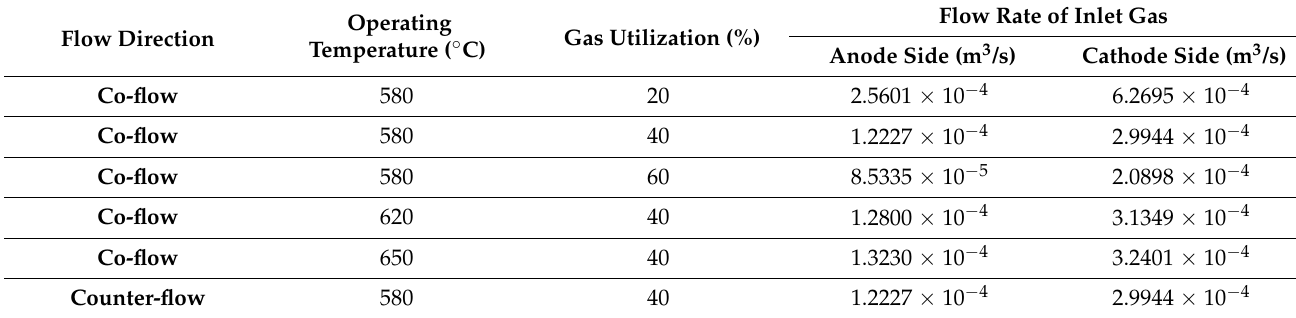
Table 3. Flow rate of inlet in the operating conditions of external reforming-type MCFCs.